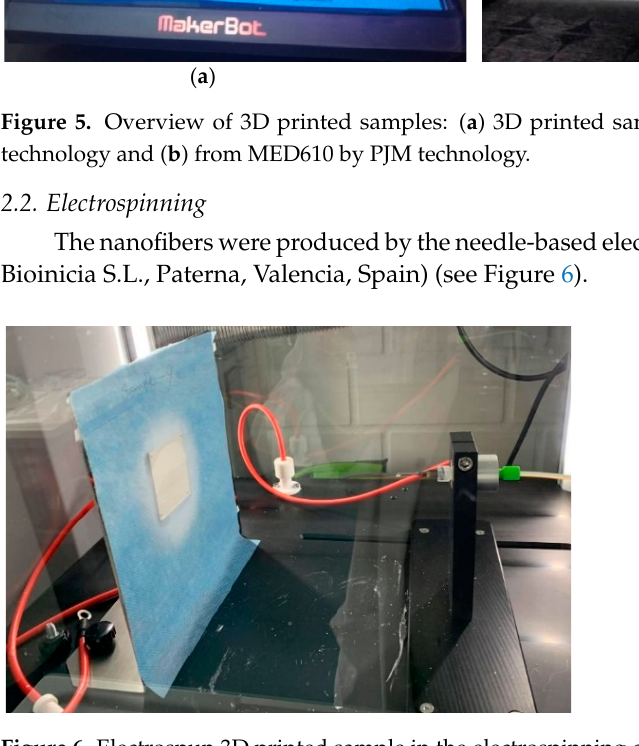
Figure 6. Electrospun 3D printed sample in the electrospinning device.